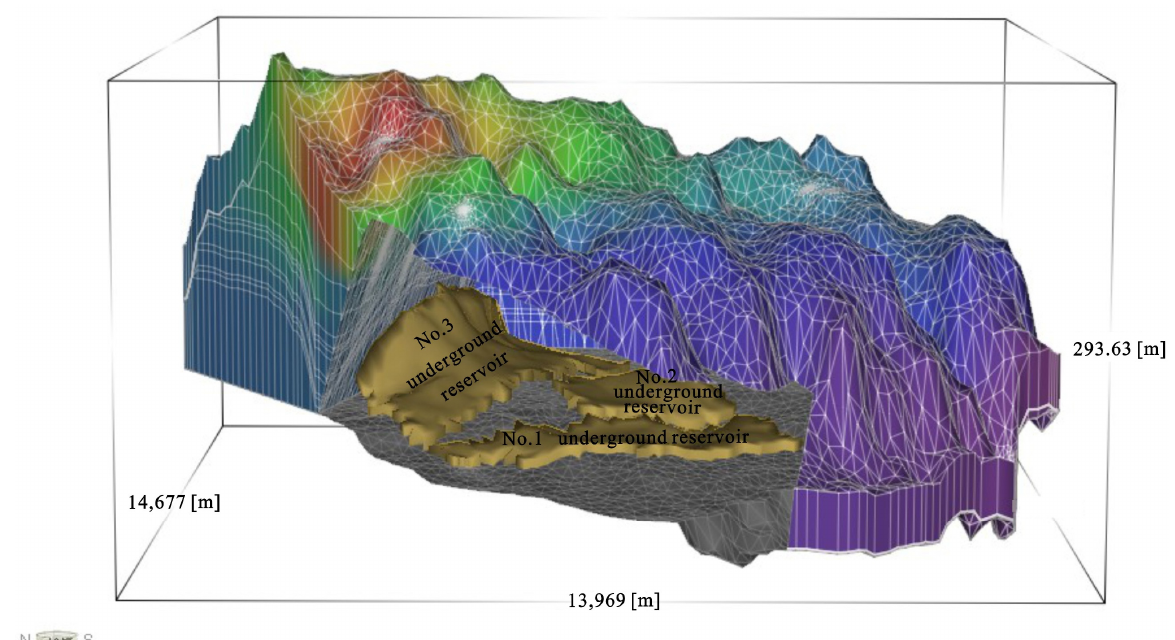
Figure 3. Simulation model of the groundwater system in the study area.